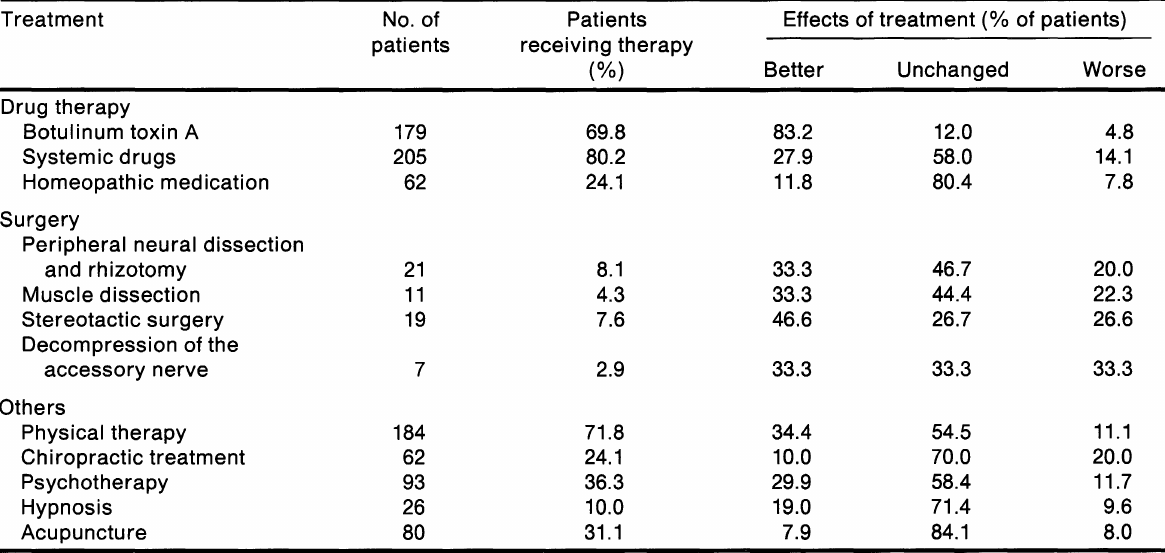
TABLE II. Forms of treatment and their effects according to the patients' assessments. Treatment with botulinum toxin A is indicated as the most effective form of treatment Treatment No.